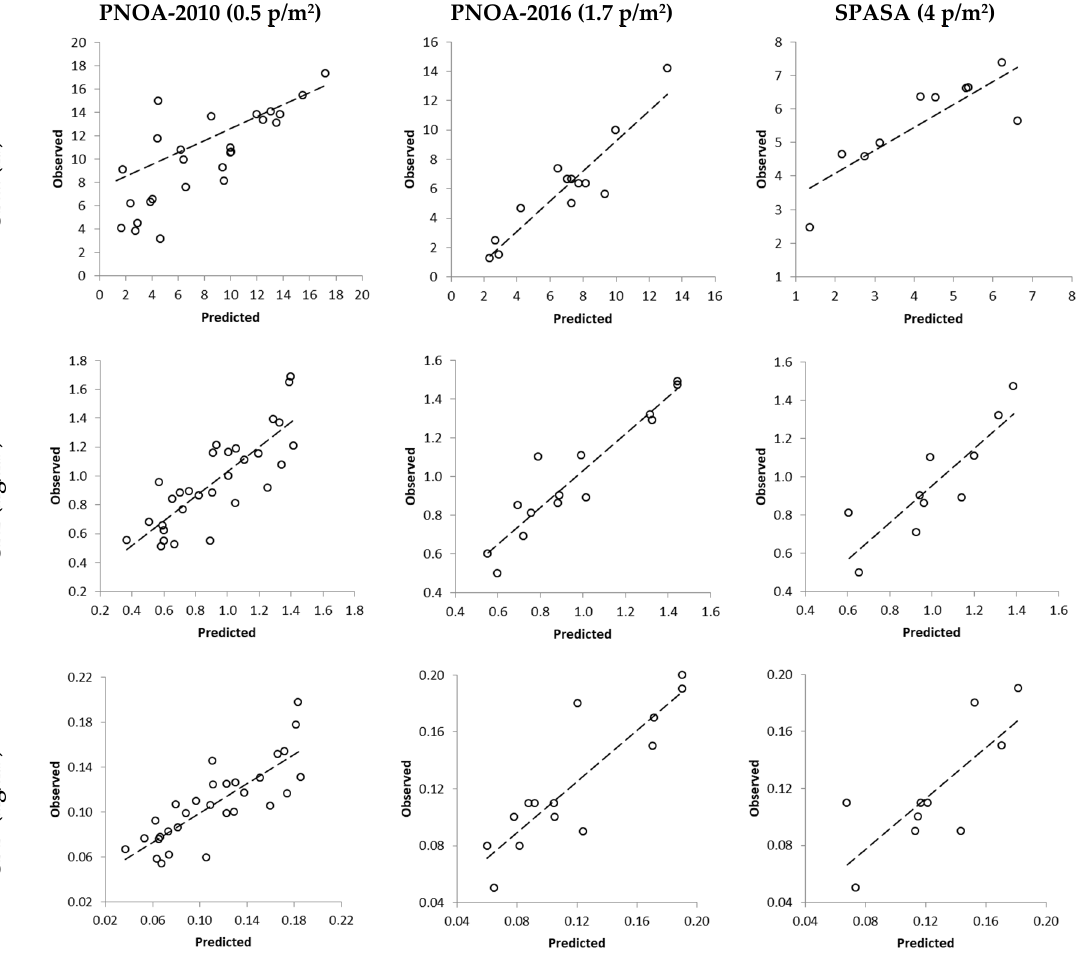
Figure 4. Observed vs. predicted values of canopy fuel attributes (CBH, canopy base height; CFL, canopy fuel load; CBD, canopy bulk density) resulting from applying the best model fitted with PNOA-2018 LiDAR data (exponential) to the LiDAR datasets available in the study area with different pulse density: PNOA-2010 ( n = 30), PNOA-2016 ( n = 14) and SPASA ( n = 10). Least square trend line (dashed) is shown.